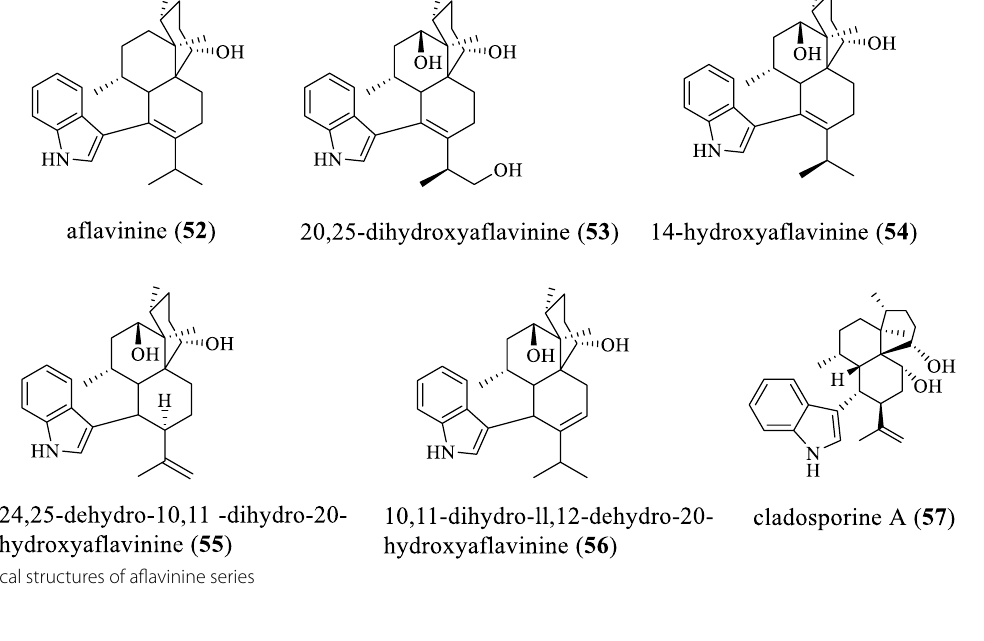
Fig. 4 Chemical structures of aflavinine series